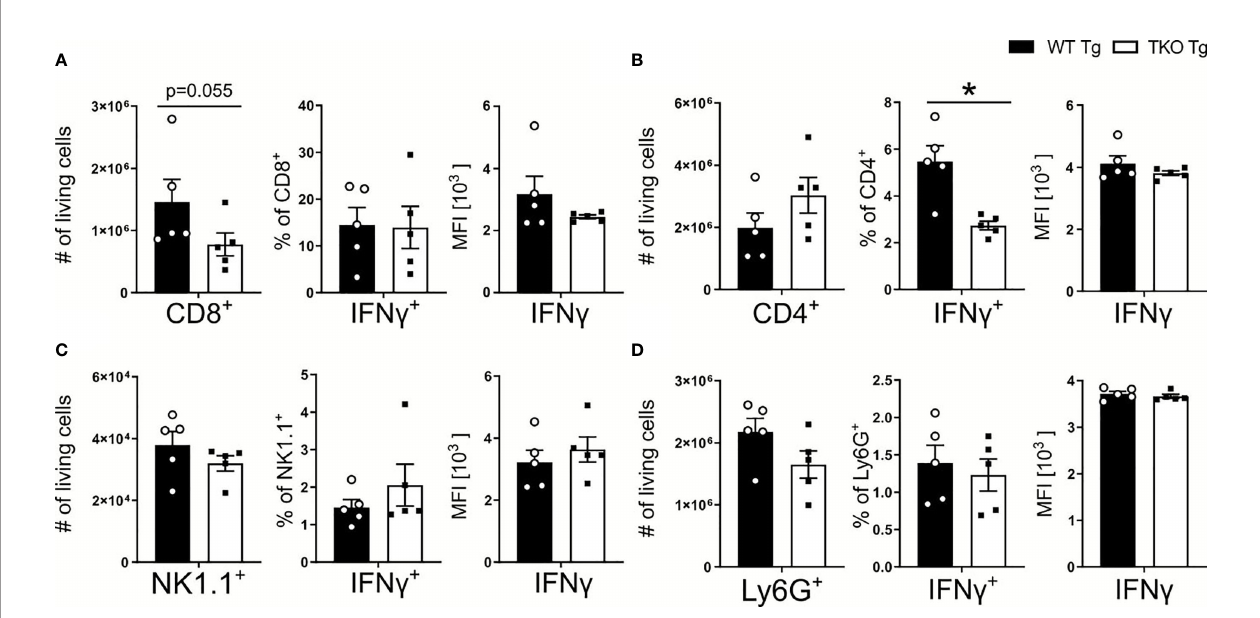
FIGURE 4 | Reduced CD8 + T cell numbers and impaired Th1 responses in T. gondii infected TKO mice. Immune cells were isolated from the spleens of T. gondii infected WT (WT Tg, n=5) and TKO (TKO Tg, n=5) mice on day 10 p.i. and analyzed by fl ow cytometry. Following viability staining and the basic FSC/SSC gating, viable single cells were determined by fi rst removing CD11b + and CD3 - immune cells. CD3 + CD4 + and CD3 + CD8 + T cells were identi fi ed for further analysis. CD45 + NK1.1 + cells were determined after gating out CD3 + , CD8 + , Ly6C + and Ly6G + cells. The total cell number of (A) CD8 + T cells, (B) CD4 + T cells, (C) NK1.1 + cells and (D) neutrophils, the percentage of IFN g producing cells and their respective IFN g production were measured. Data shown represents three independent experiments; symbols represent individual animals, columns represent mean values and error bars represent ± SEM. A Mann-Whitney test was used for statistical analysis. *P <